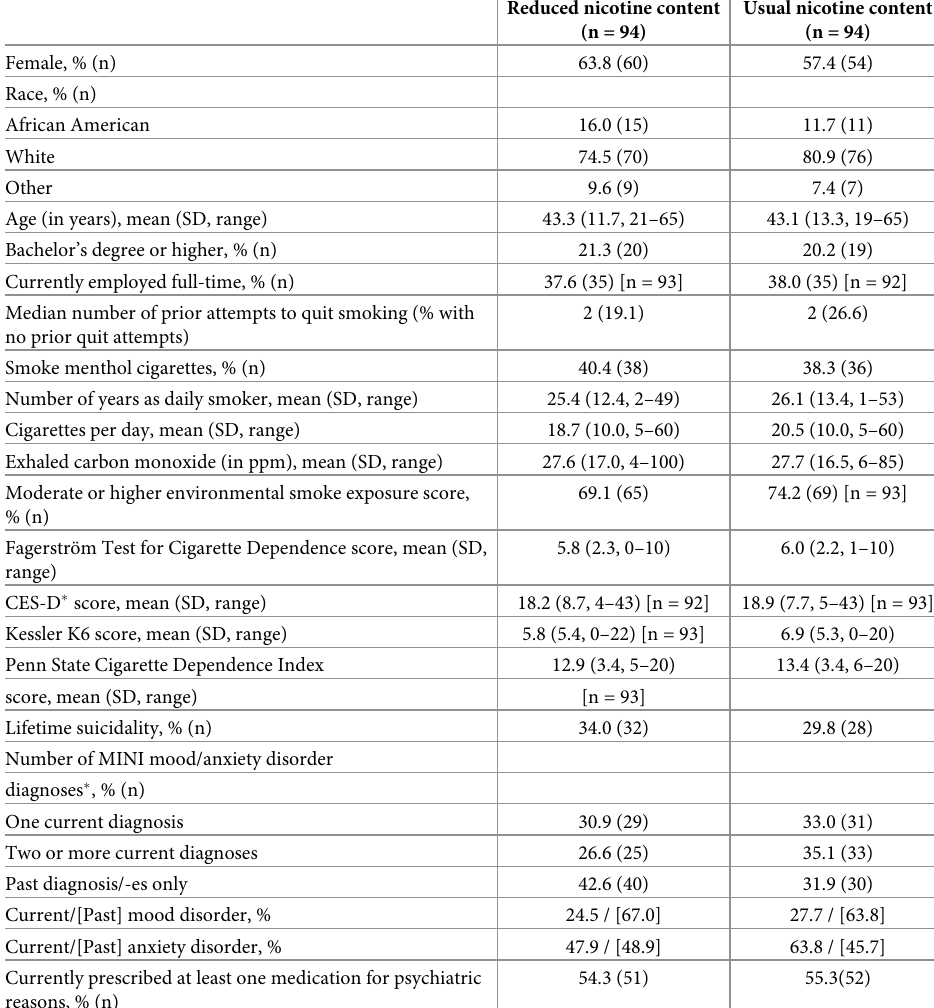
Table 1. Study participant demographic and smoking characteristics pre-randomization.